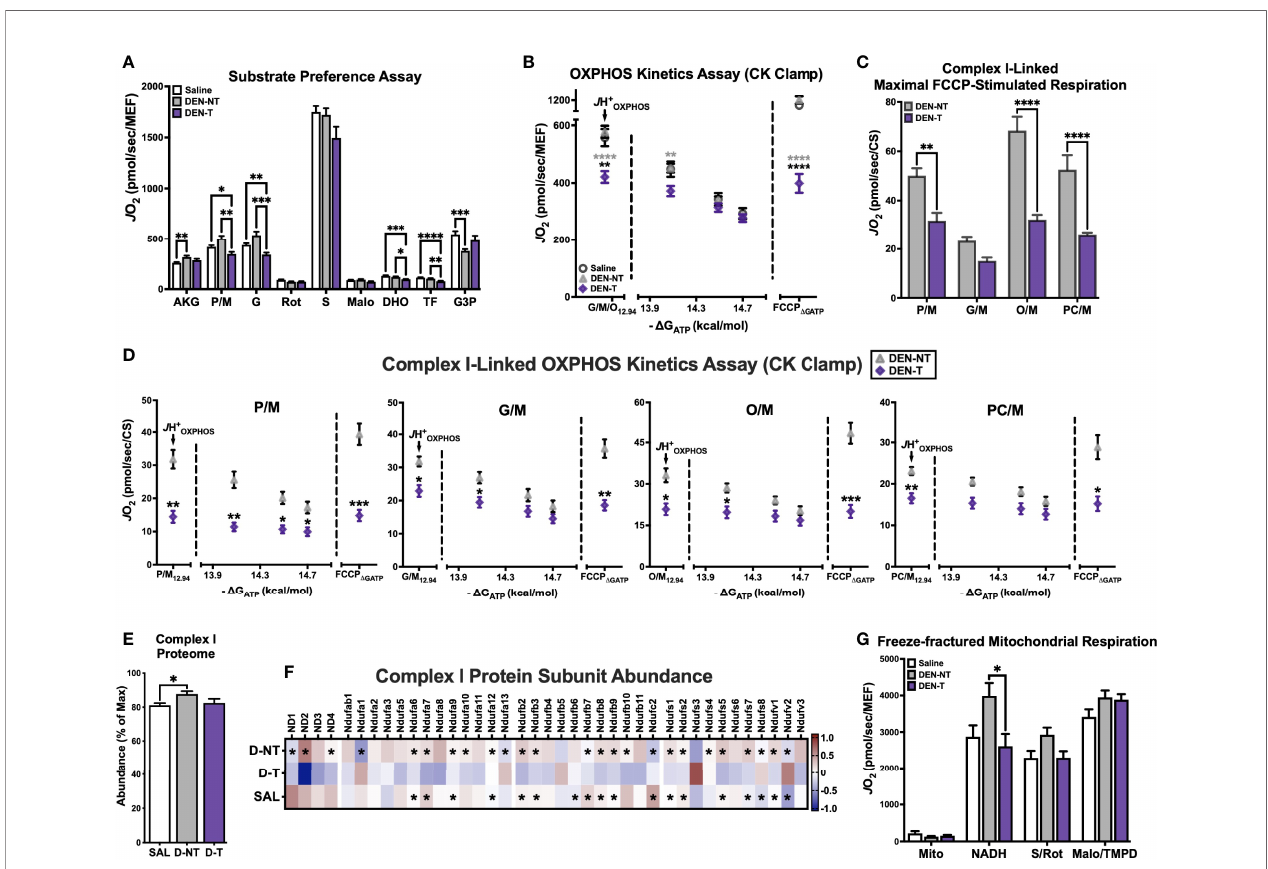
FIGURE 4 | DEN tumor-derived mitochondria exhibit complex I-linked respiratory de fi ciency. (A) Substrate preference assay stimulated with 500 m M ADP clamped by HK clamp. Substrate/inhibitor additions were as follows: AKG (10mM), P/M (5/1mM), G (10mM), Rot (0.5 m M), S (10mM), Malo (20mM), DHO (10mM), TF (20 m M), G3P (5mM). (B) OXPHOS kinetics protocol fueled by G/M/O. (C) Maximal FCCP-stimulated rates when fueled by 4 different complex I-linked carbon substrates (P/ M, G/M, O/M, PC/M); data normalized to CS activity. (D) OXPHOS kinetics protocols fueled by P/M, G/M, O/M, PC/M; data normalized to CS activity. (E) Relative abundance of complex I subunits expressed as % of highest summed abundance. (F) Heatmap of complex I protein subunit expression; asterisks denote signi fi cant difference from DEN-T (q<0.1). (G) Respiration in freeze-fractured mitochondrial preparations. Data are presented as mean ± SEM and analyzed by two-way ANOVA (A – D, G) and one-way ANOVA (E) . *p < 0.05, **p < 0.01, ***p < 0.001, ****p <